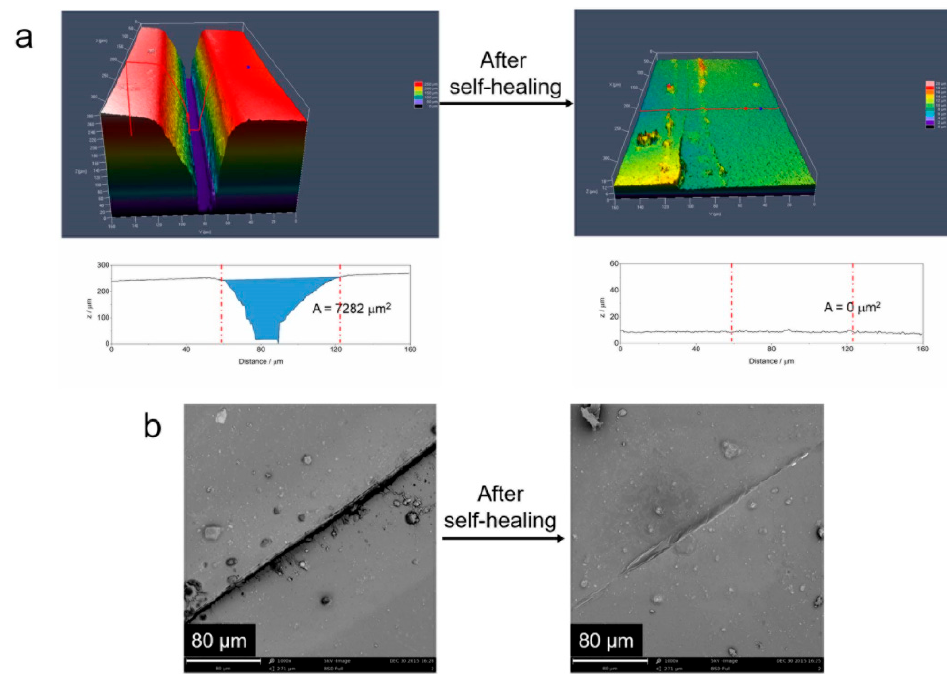
Figure 12. Self-healing properties of the β -CD-TiO 2 /P(HEMA-co-BA) coating: ( a ) Super-resolution confocal microscope images of the coating before and after self-healing—the upper image is a contour view and the lower image is a cross-sectional view; ( b ) SEM image of the coating before and after self-healing.